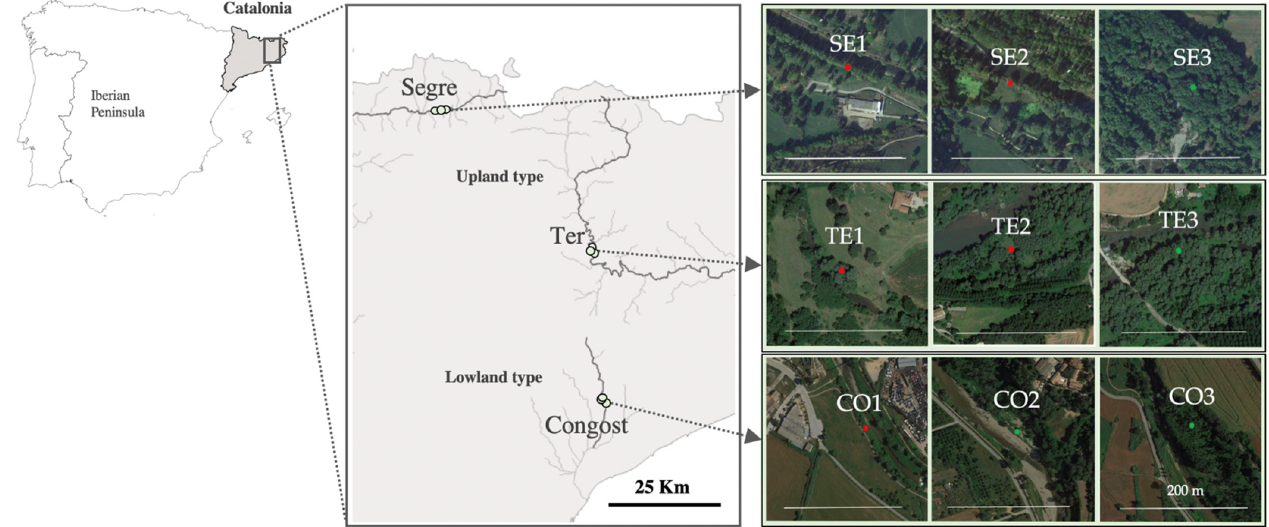
Figure 1. Geographical location and aerial photo of the nine sampling sites at the Catalonian river corridors. Red and green points indicate disturbed and less disturbed sites, respectively.